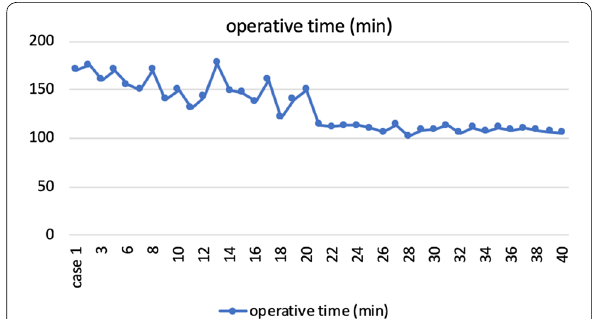
Fig. 3 Learning curve for single laparoscopic urology trainee